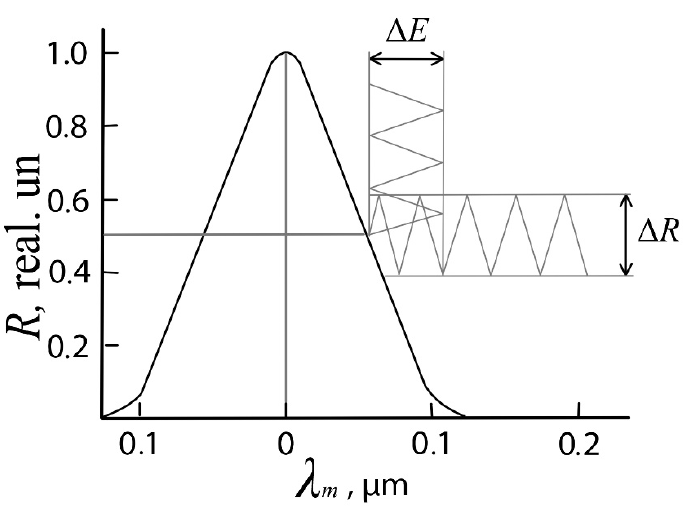
Figure 9. Dependence of the value of the reflection coefficient R on the change in the resonant wavelength.